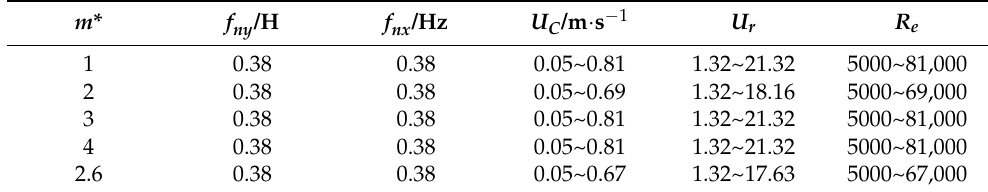
Table 1. Data table of calculation